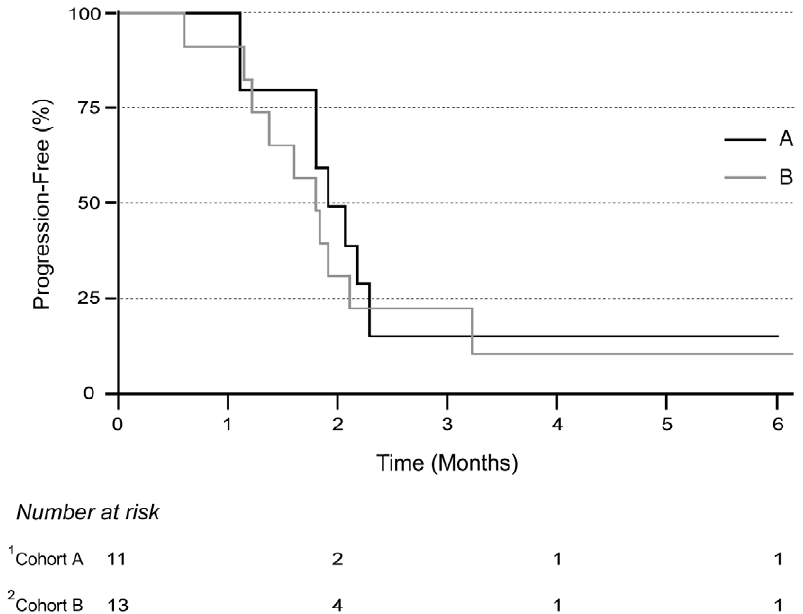
Figure 2. Kaplan-Meier analysis of time to progression. 1 Cohort A: no previous chemotherapy; 2 Cohort B: up to two prior chemotherapeutic regimens.